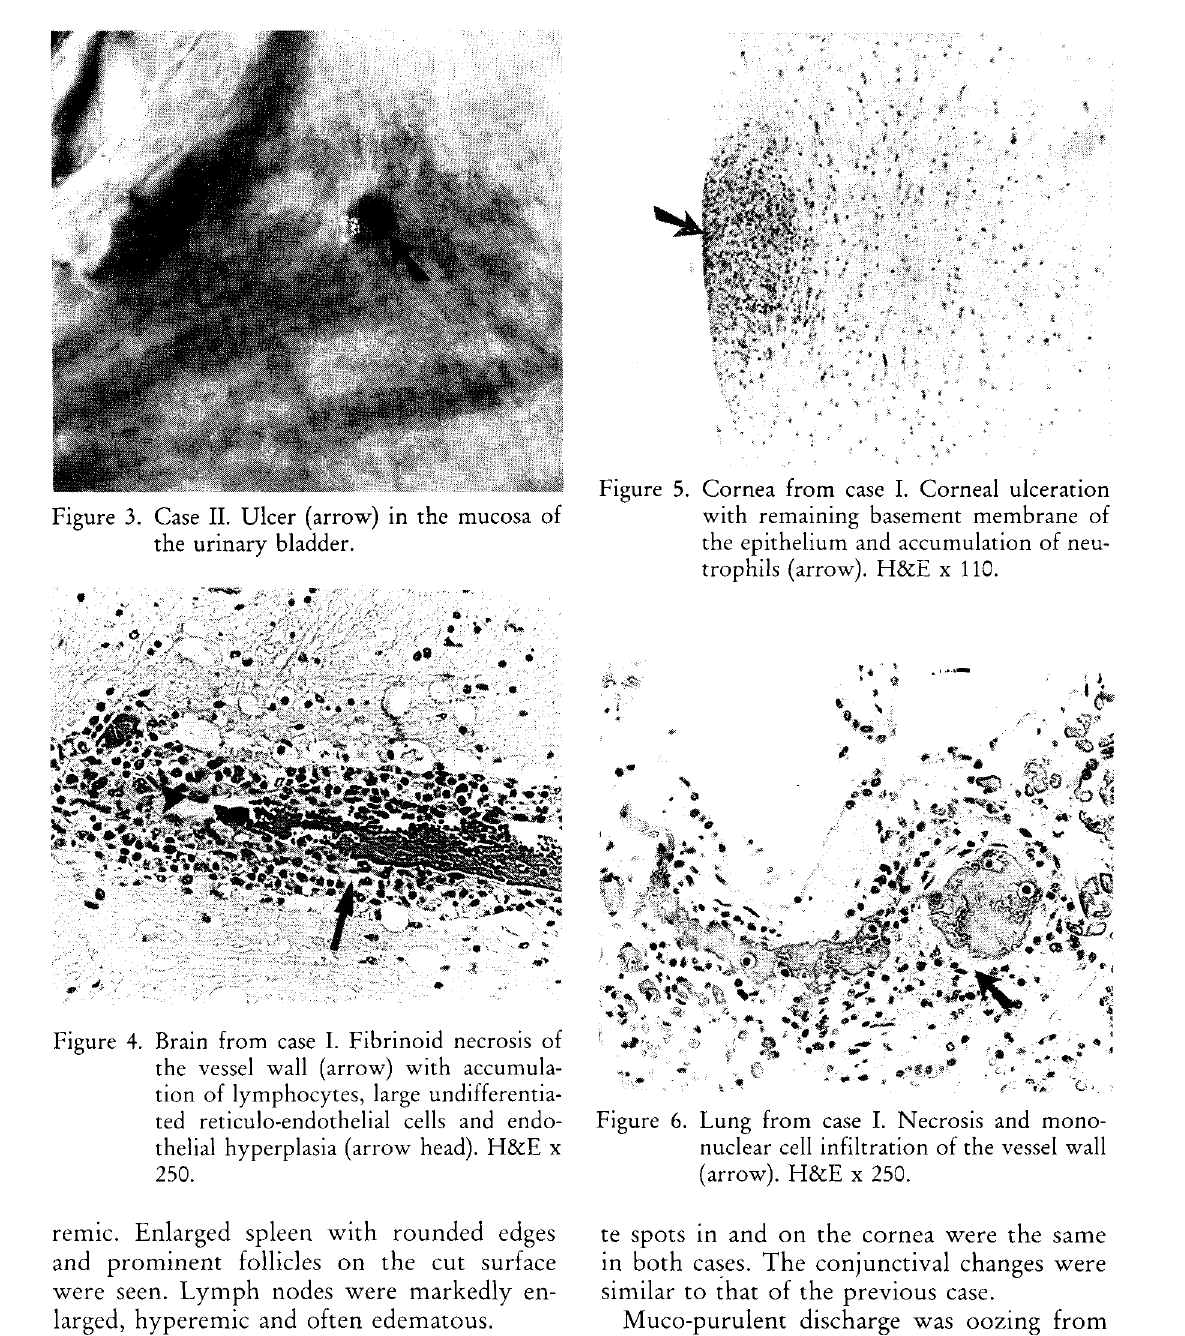
Figure 4. Brain from case I. Fibrinoid necrosis of the vessel wall (arrow) with accumula tion of lymphocytes, large undifferentia ted reticuloendothelial cells and endo thelial hyperplasia (arrow head). H&E x 250.